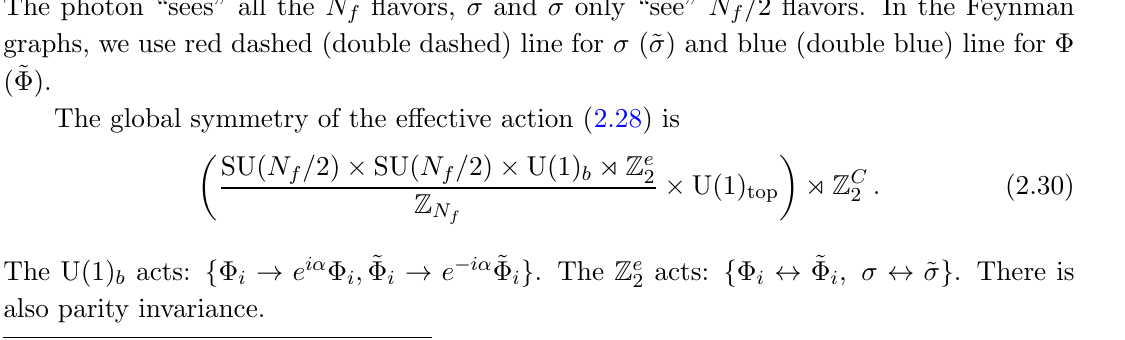
The U(1) also parity